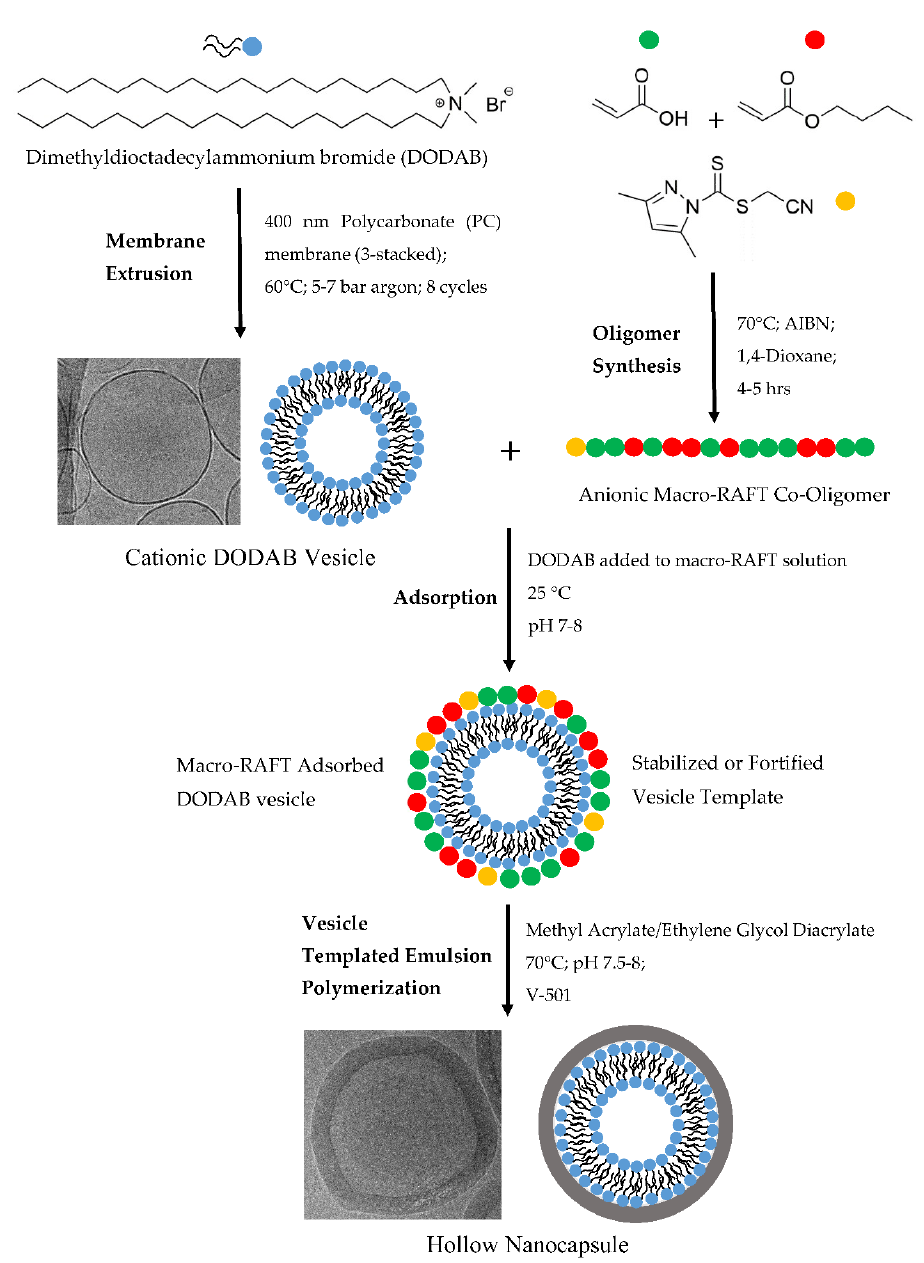
Figure 1. Nanocapsule synthesis via vesicle templated RAFT-based emulsion polymerization.